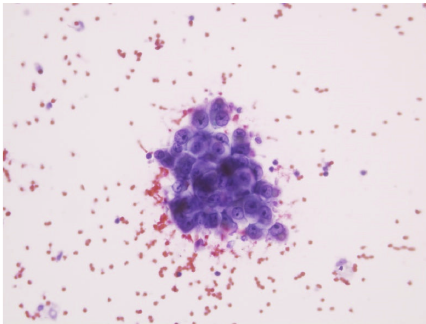
Figure7:CSFcytospinsmearshowingatypicalcellsinsmallclusters with intracytoplasmic melanin